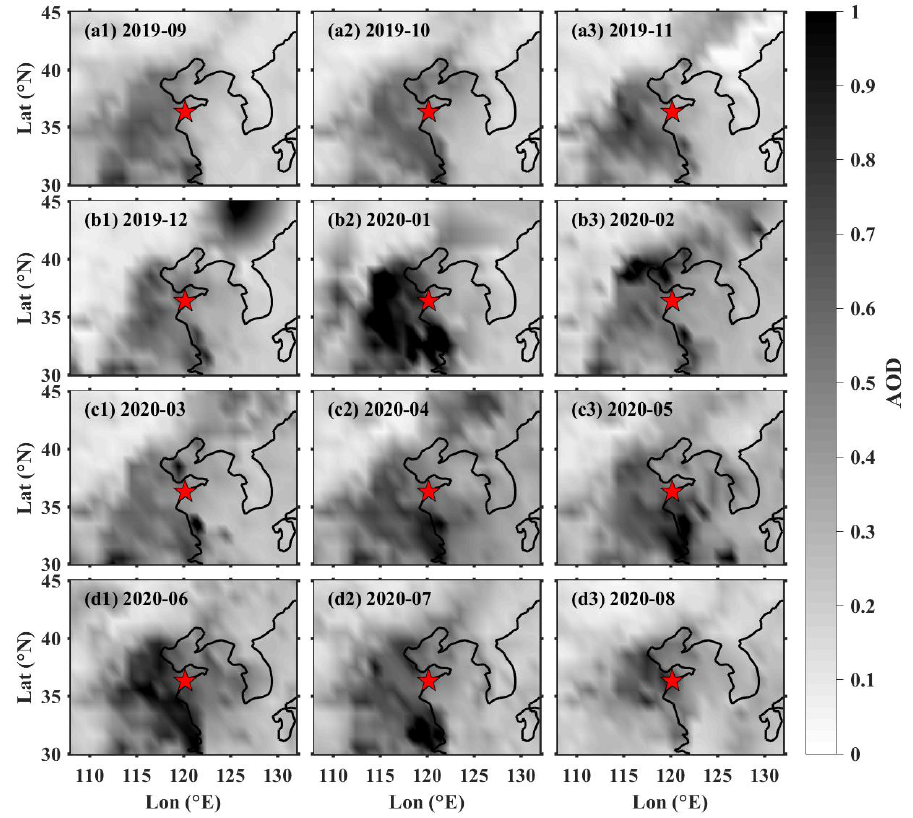
Figure 3. Monthly MODIS AOD from September 2019 to August 2020. The red five-pointed star in each plot denotes the location of Qingdao.